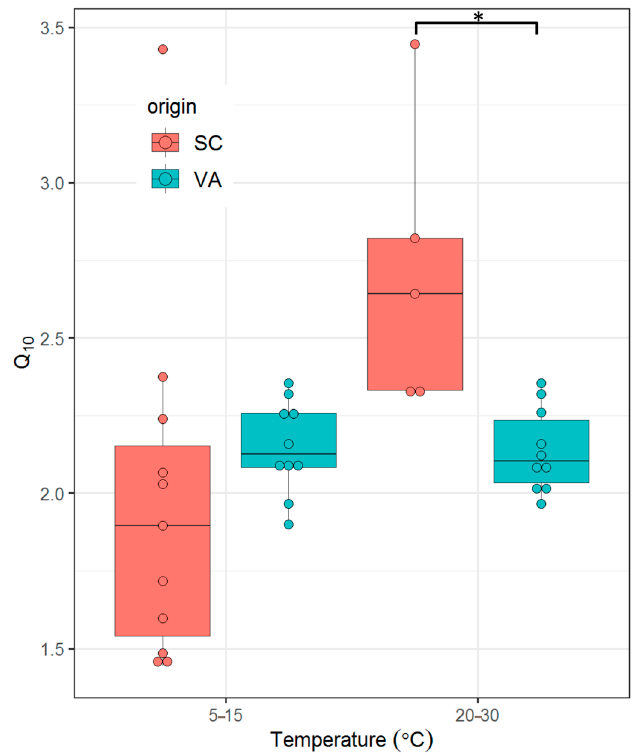
Figure 6. Temperature coefficient (Q 10 ) of spotted seatrout between northern and southern spotted seatrout populations subjected to cold stress (5 to 15 °C) and heat stress (20 to 30 °C). SC = southern population, VA = northern population. Asterisks indicate significant differences between groups ( p ≤ 0.05, two tailed Student’s t-test).